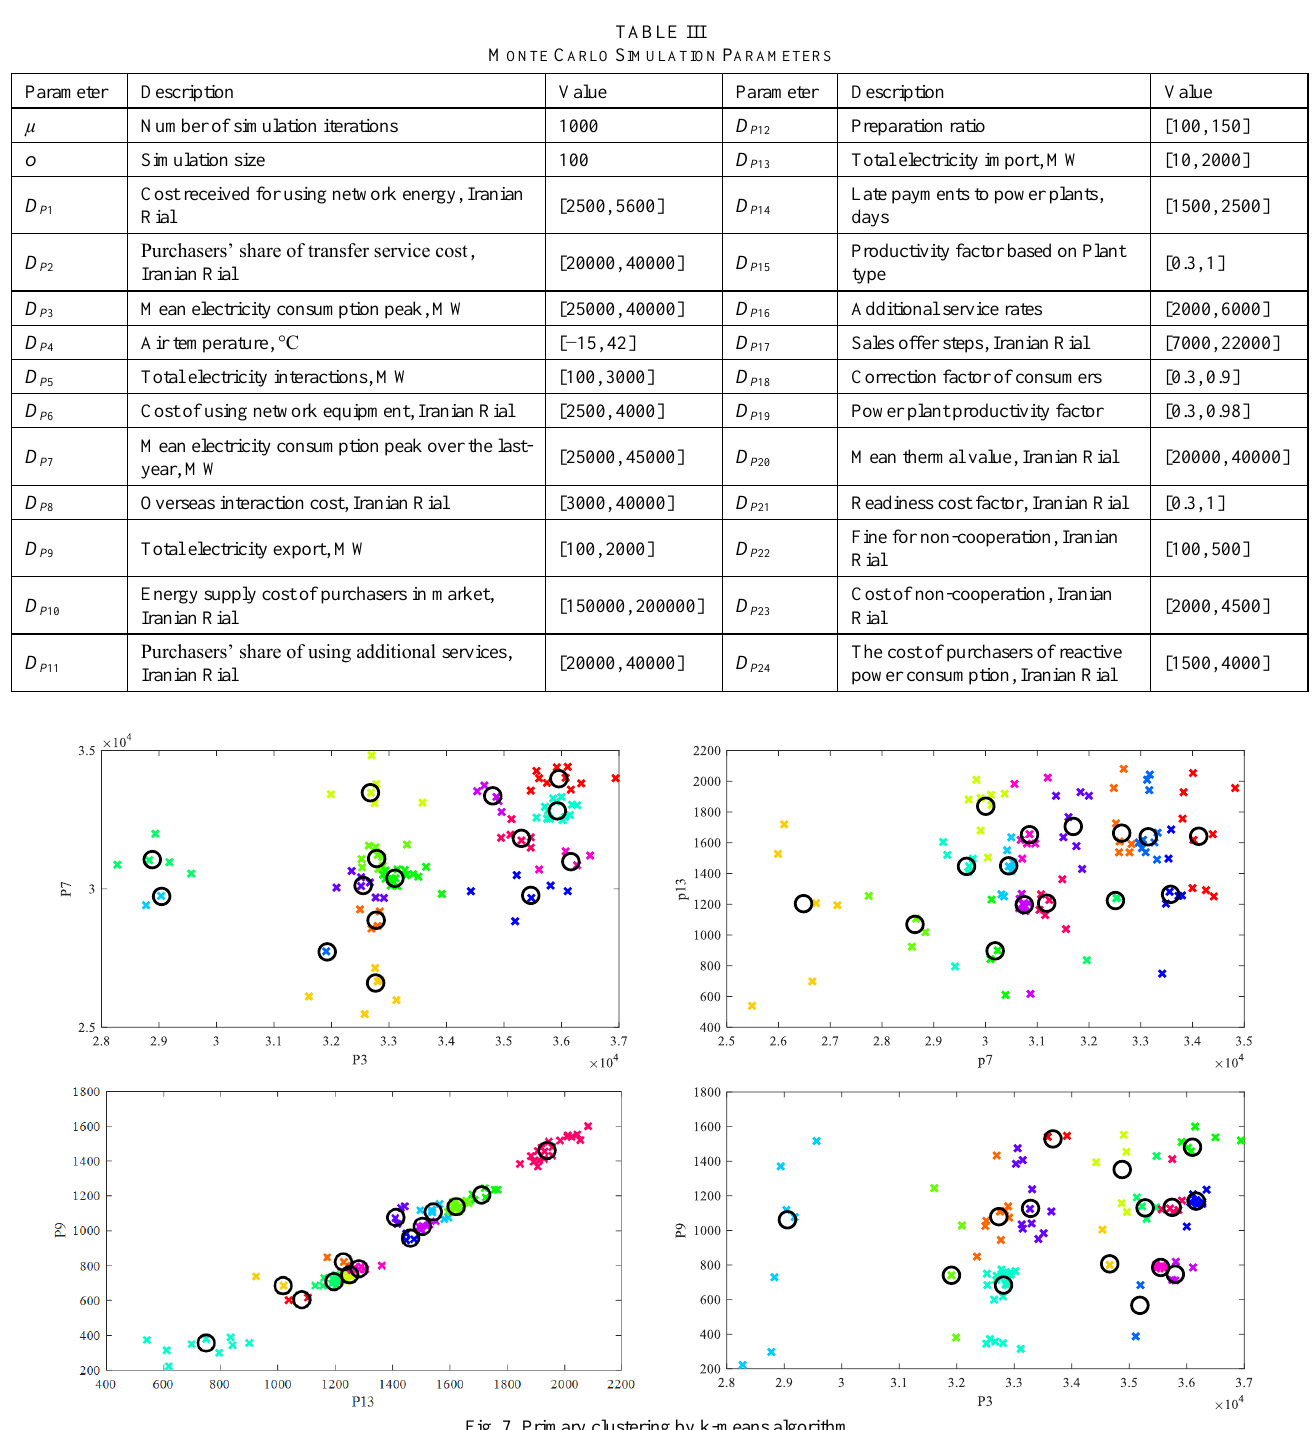
Fig. 7. Primary clustering by k-means